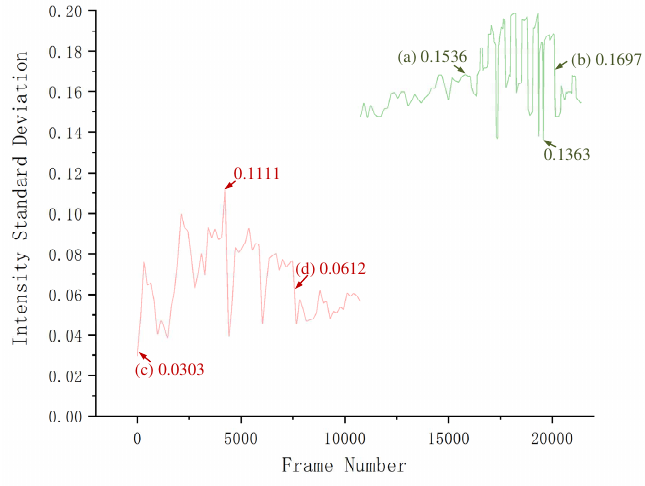
Figure 11. Intensity standard deviation under different sea wave background.